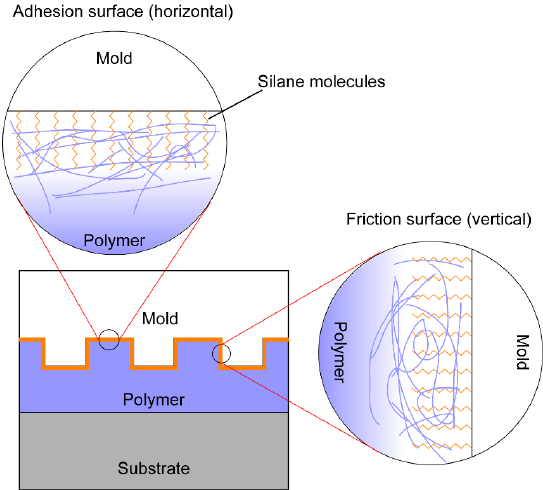
Figure 8. Schematic of chain entanglement between silane molecule and polymer resist.